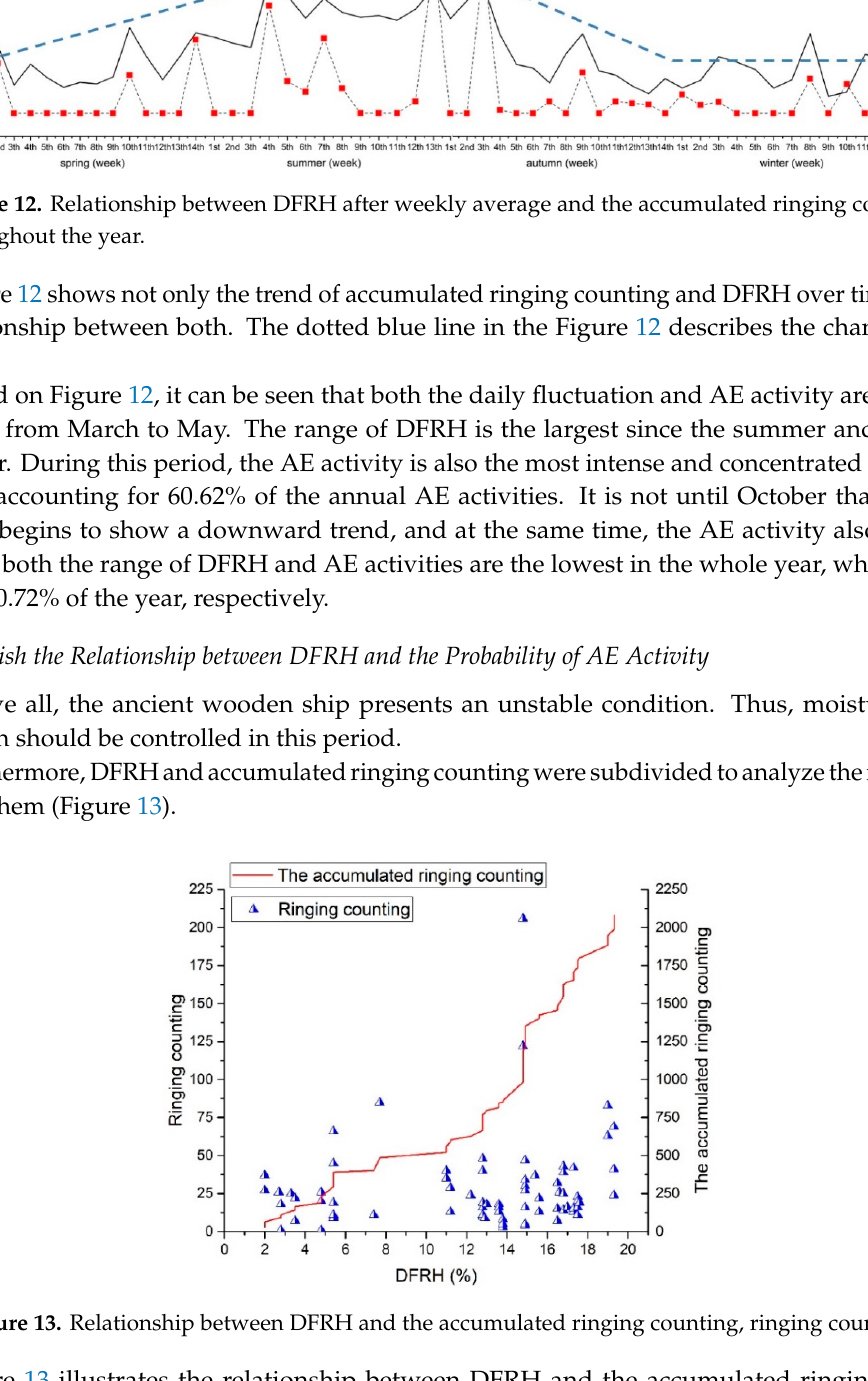
Figure 13. Relationship between DFRH and the accumulated ringing counting, ringing counting.